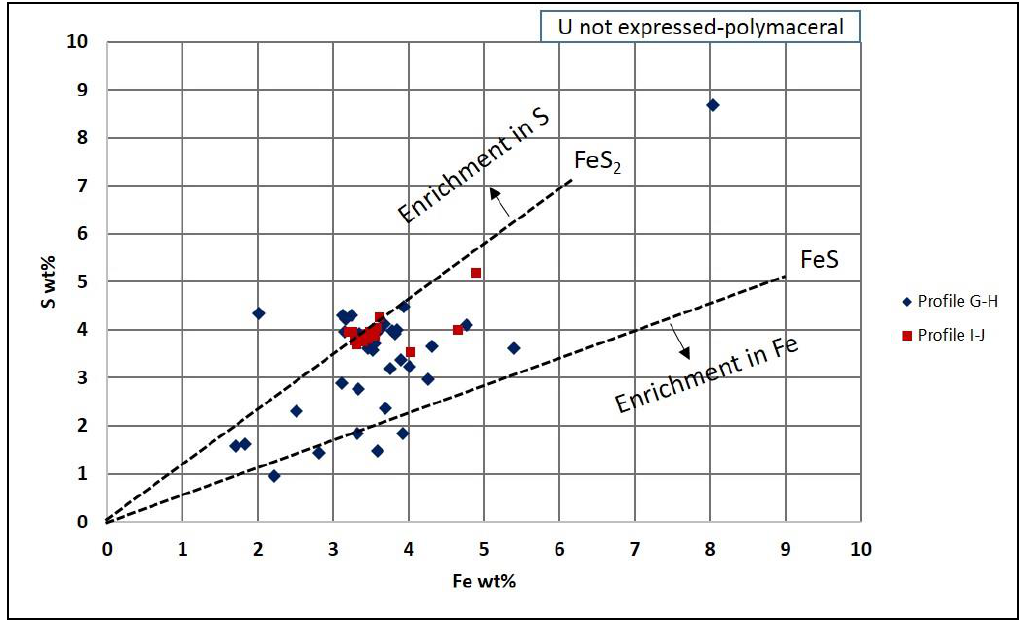
Figure 7. S–Fe binary plot, illustrating profiles G-H and I-J presented in Figure 5. Reference lines